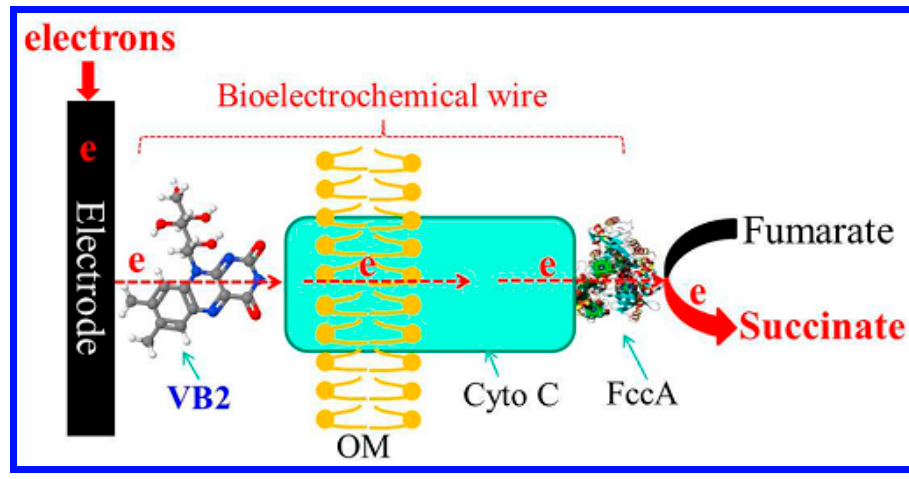
Figure 6. A schematic diagram illustrating the electron transfer pathway used in bioelectrochemically-based whole cell biosensors. OM indicates the outer cell membrane; Cyto C represents cytochrome C proteins; and FccA indicates fumarate reductase. Reprinted with permission from [91].